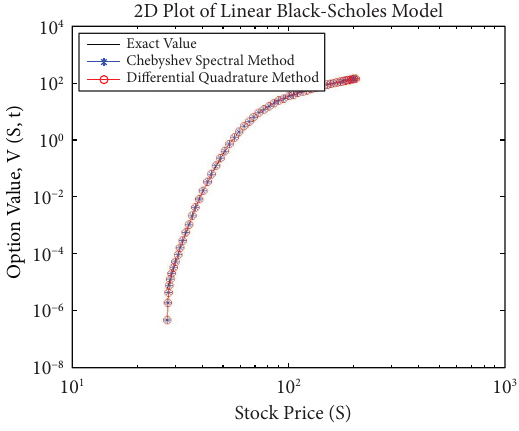
Figure 10: 2D plot of the linear Black-Scholes model at t �